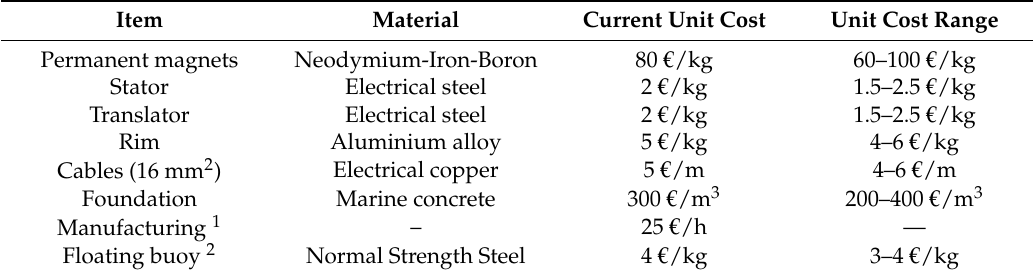
Table 1. Material and manufacturing